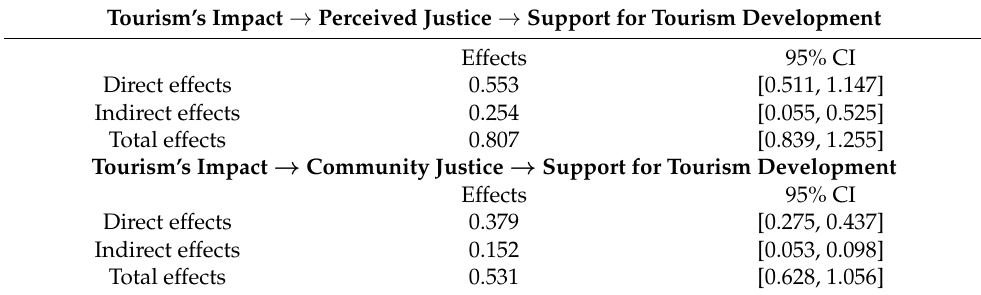
Table 5. Mediating effect test of perceived justice and community